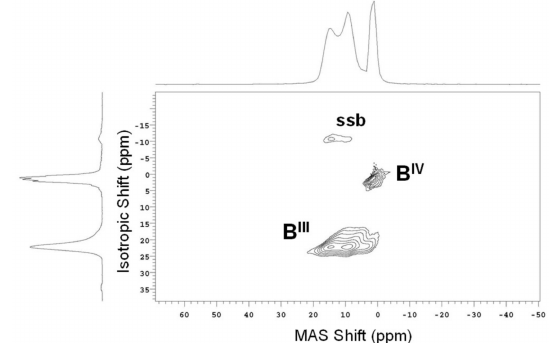
Figure 3. 11 B multiple quantum magic angle spinning (MQMAS) NMR spectrum of a binary sodium borate glass (15.4 mol % Na 2 O), measured at 11.7 T, using a 3.2-mm MAS NMR probe (sample volume ~22 µ L). B III and B IV resonances are detected as separate sets of contours, and within the B III signal is evidence for multiple environments corresponding to ring and non-ring B III . Traces to the left and top correspond to data projections onto the isotropic and MAS shift axes, respectively. Fine structure in the B IV isotropic projection is from data truncation. Reproduced from [20] with permission from the PCCP Owner Societies.